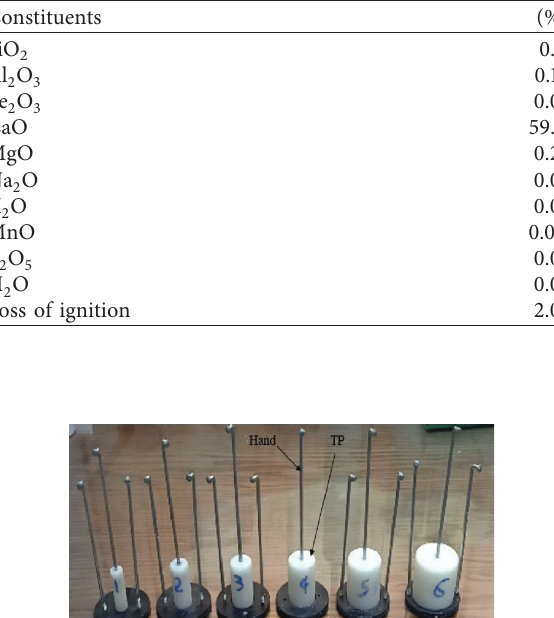
Table 4: Chemical composition of hydrated lime.